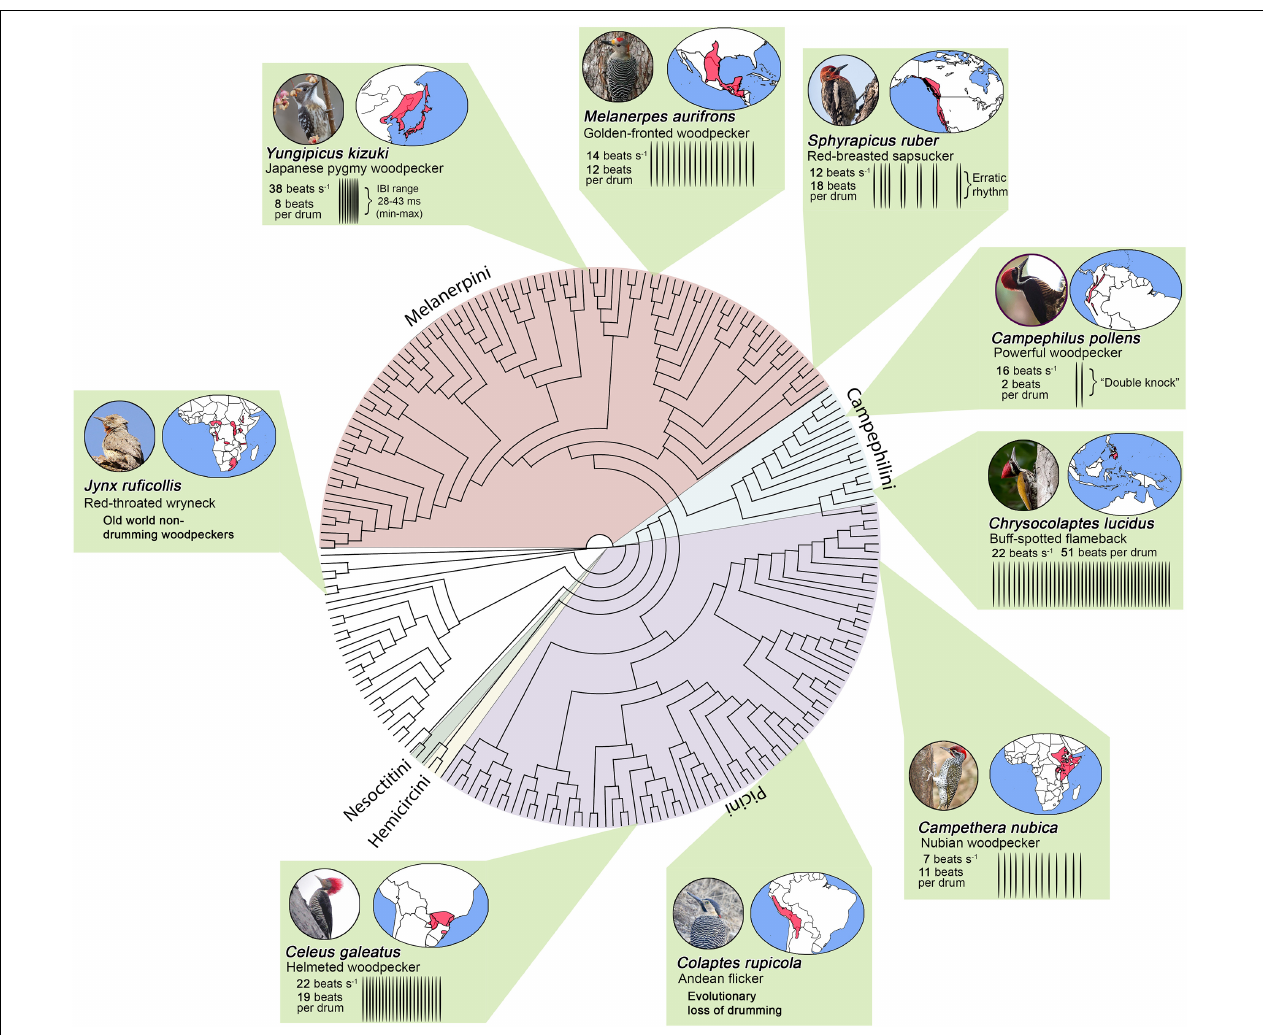
FIGURE 2 | Cladogram of the woodpeckers (Picidae) from Shakya et al. (2017). Colors within the phylogenetic tree illustrate the five main woodpecker tribes and non-drumming old world woodpeckers (e.g., wrynecks). Green boxes illustrate how drums vary across the woodpecker phylogeny. Woodpecker drums differ in terms of speed (beats/sec), length (total number of beats), and rhythm (Miles et al., 2018, 2020). The Japanese pygmy woodpecker ( Yungipicus kizuki ) exhibits the fastest drums. This species is able to strike its bill at rates that can exceed 38 beats s − 1 (or a strike every 28–43 ms). The buff-spotted woodpecker ( Chrysocolaptes lucidus ), a species found throughout eastern Asia, exhibits one of the longest drums ( ∼ 51 beats per drum). Some birds also exhibit drums with a-typical patterns. For instance, sapsuckers exhibit erratic drum rhythms, and the Powerful woodpecker produces “double-knocks” rather than the longer drums seen in most woodpeckers. Boxes also illustrate that woodpeckers occupy diverse habitats throughout the world. Photo credits: Japanese pygmy woodpecker (Ik T, CC BY 2.0); golden-fronted woodpecker (Roberto González, CC BY 2.0); red-breasted sapsucker (Beck Matsubara, CC BY 2.0); powerful woodpecker (Alan Harper, CC BY 2.0); buff-spotted flameback (Tareq Ahmed, CC BY 2.0); nubian woodpecker (Brad Schram, CC BY 2.0); Andean flicker (Vil Sandi, CC BY 2.0); helmeted woodpecker (Hector Bottai, CC BY 3.0); and red-throated wryneck (Derek Keats, CC BY 2.0). No photographs have been